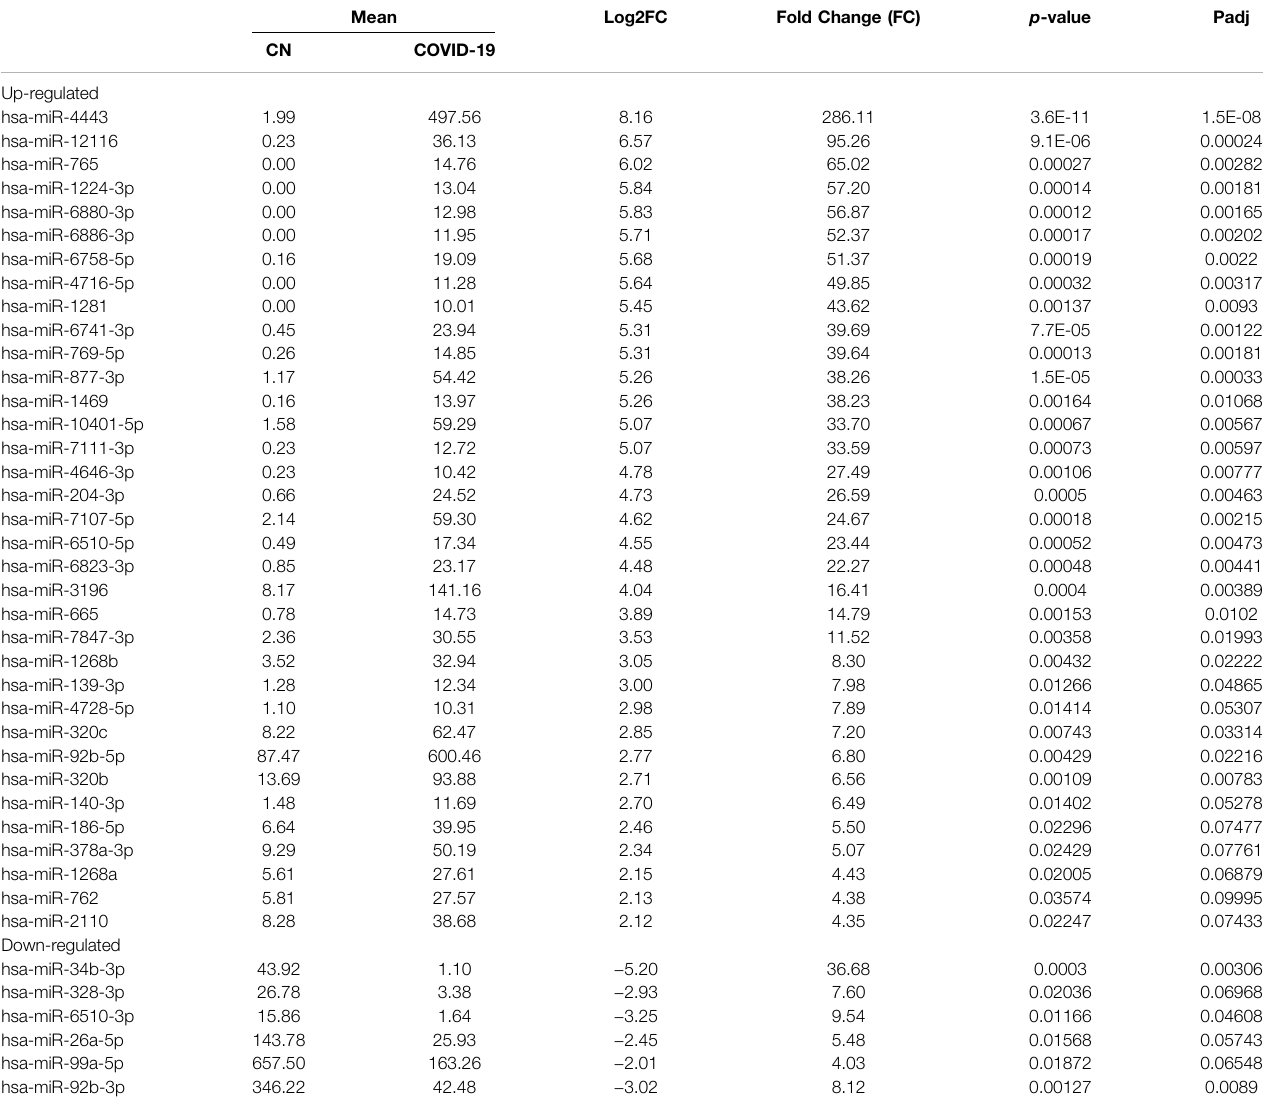
TABLE 3 | Changes in miRNAs by